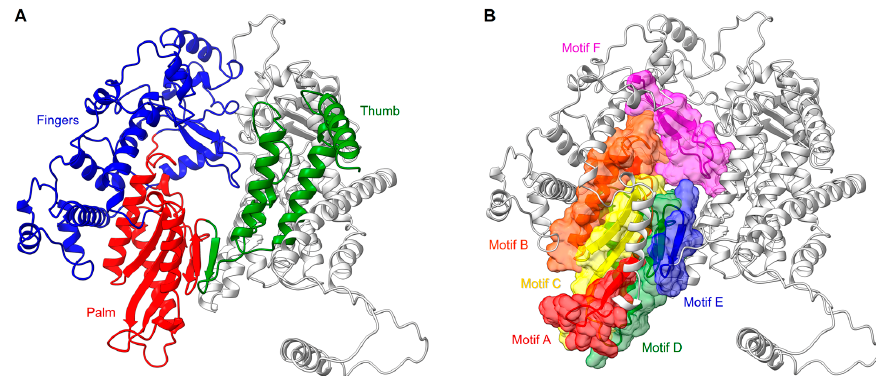
Figure 2. RSV RdRp features. ( A ) RdRp subdomain organization shown in ribbons with the palm in red, the fingers in blue, the thumb in green, and the remaining supporting structure in light gray. ( B ) Same position as in ( A ) with sequence motifs (A–F) of the active site shown in colored ribbons and highlighted surfaces.